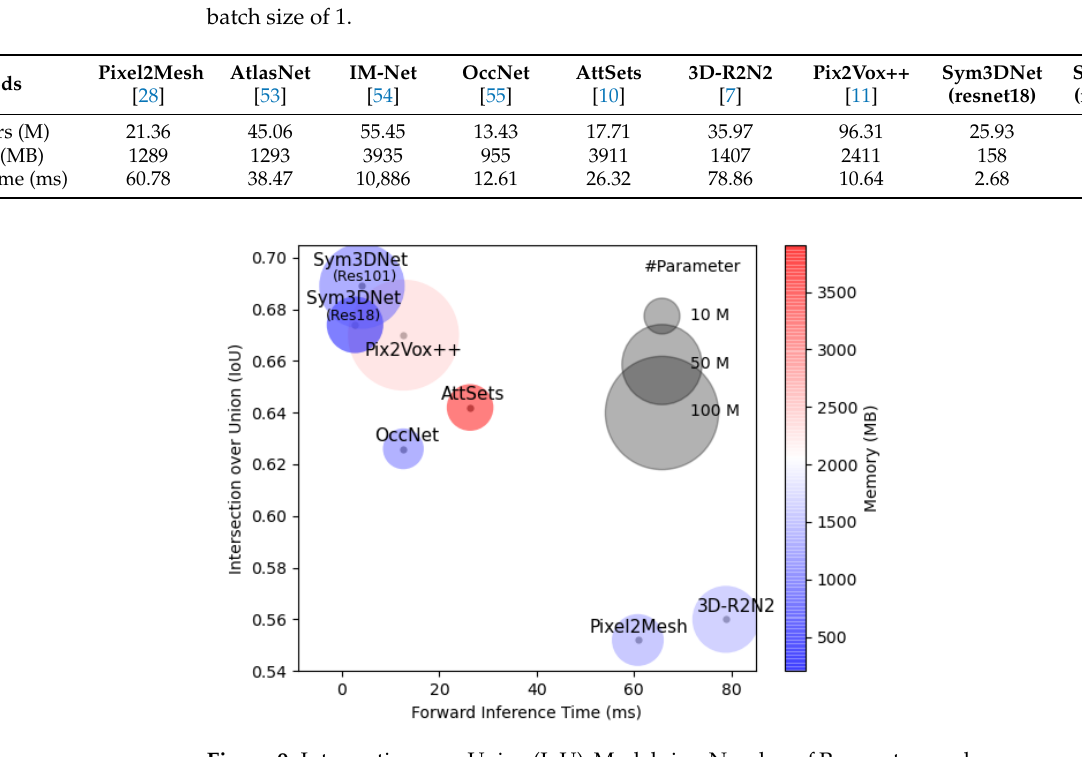
Figure 9. Intersection over Union (IoU), Model size, Number of Parameters and memory consumption of state-of-the-art methods for 3D shape reconstruction from single-view: The radius of the circle represents the size of corresponding models with respect to the number of parameters. Color of the circles represents the memory usage by the respective model (blue is lower and red is higher). In terms of inference time, IoU, and Memory usage, the proposed method outperforms all state-of-the- art